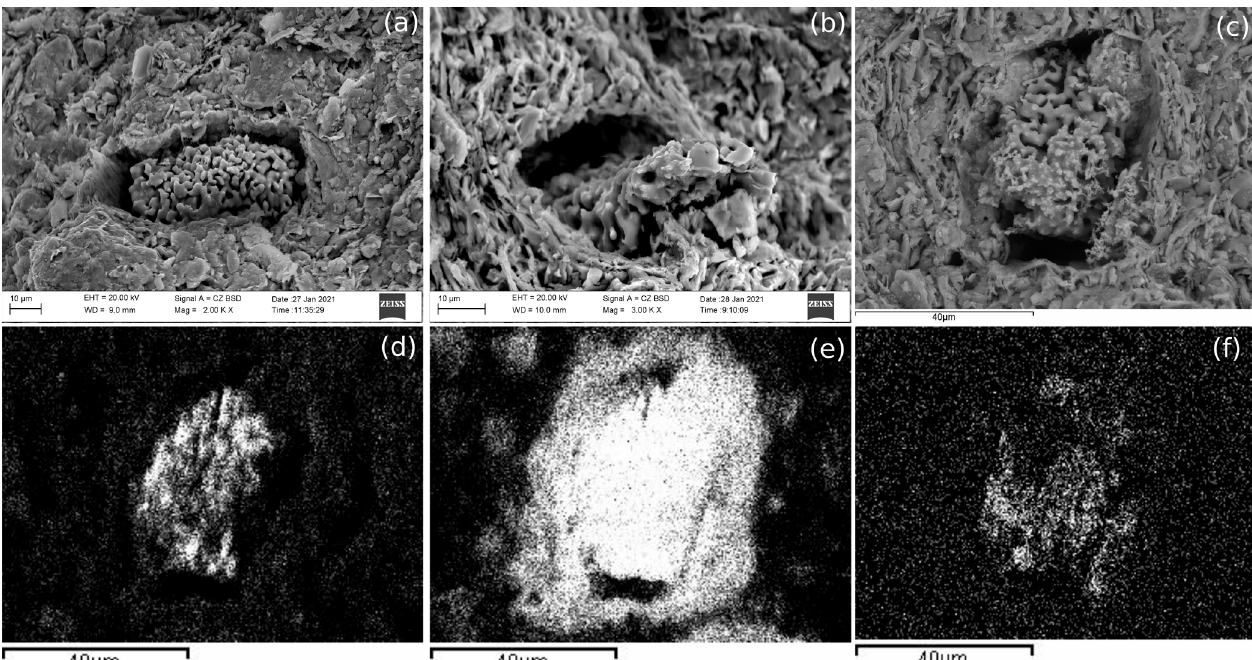
Figure 7. SEM-BSD image of the common crystallization identified in PT and PF samples; ( a ) Ca-F aggregate in a cavity of PF008, a sample immersed in tap water; ( b ) Ca-F aggregate in a cavity of PF012, a sample immersed in tap water; ( c ) Ca-F aggregate in a cavity of PF013, a sample immersed in tap water; ( d ) elemental mapping: the distribution of F in the Ca-F aggregate of ( c ); ( e ) elemental mapping: the distribution of Ca in in the Ca-F aggregate of ( c ); ( f ) elemental mapping: the distribution of Mn in in the Ca-F aggregate of ( c ).